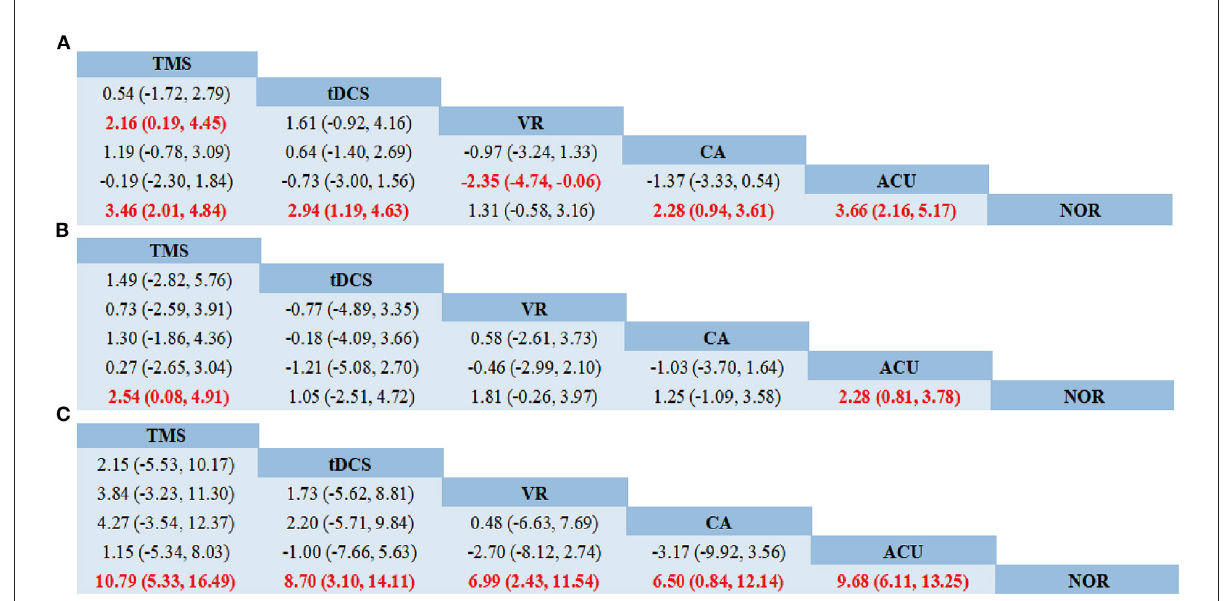
FIGURE4 Network meta-analysis of head-to-head comparisons. (A) MOCA, (B) MMSE, (C) BI. Data are MD (95% CI) in the column-defining treatment compared with the row-defining treatment. Significant results are highlighted in red and bold. TMS, Transcranial Magnetic Stimulation; VR, Virtual Reality Exposure Therapy; CA, Computer-assisted cognitive rehabilitation; tDCS, Transcranial Direct Current Stimulation; Acu, Acupuncture; NOR, Normal rehabilitation.